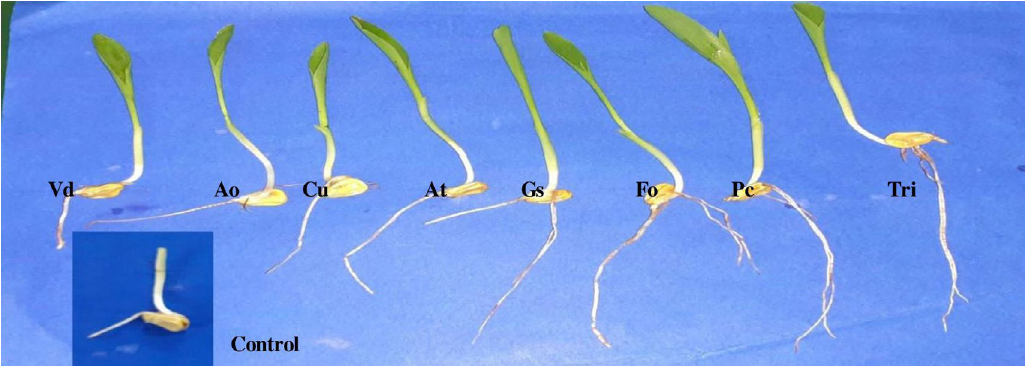
Fig. 6. Influence of endophytic fungal extracts on root growth of maize seedings.